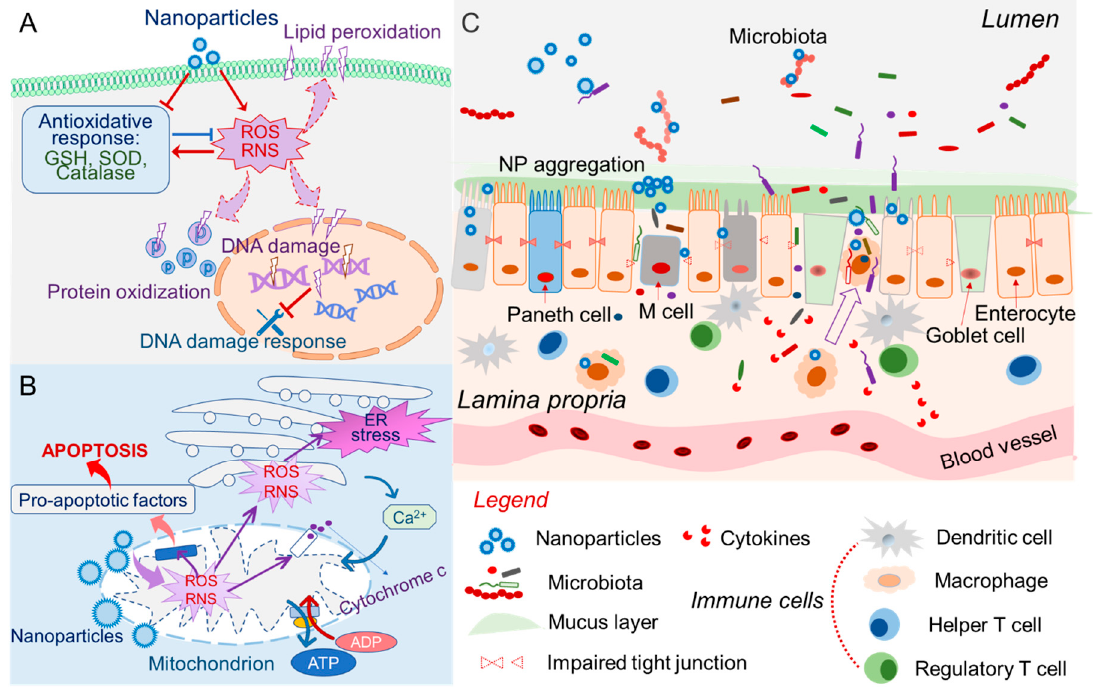
Figure 1. Mechanisms of oral nanotoxicity: ( A ) nanoparticle-induced oxidative stress; ( B ) nanotoxicity of intracellular organelle damages; and ( C ) nanoparticle-induced microbiota abnormality, immune responses, and damages to the gut barrier and luminal environment.